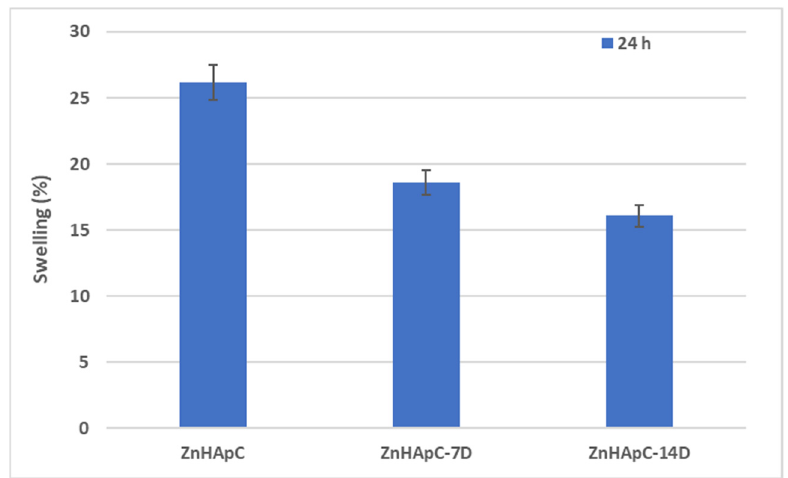
Figure 6. Aqueous swelling percentage of ZnHApC, ZnHApC-7D, and ZnHApC-14D